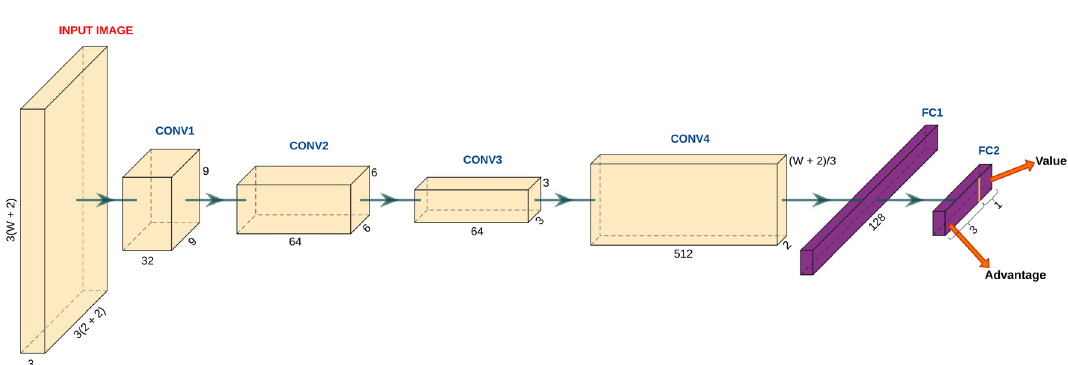
Figure 3. Illustration of network architecture ( W = window size). The filter shape at each step is represented by the dimension of the corresponding convolution block. Input to the network is an RGB